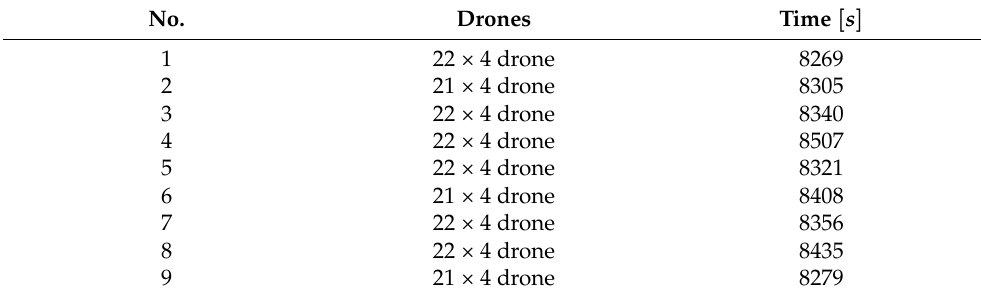
Table 1. Results of simulations with four